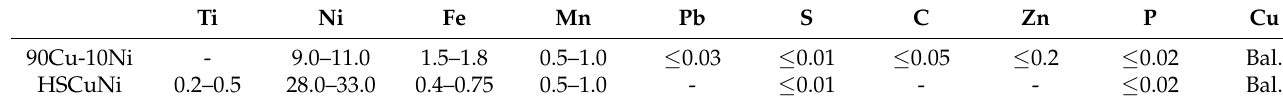
Table 1. Chemical compositions of 90Cu-10Ni cupronickel and HSCuNi (wt.%).